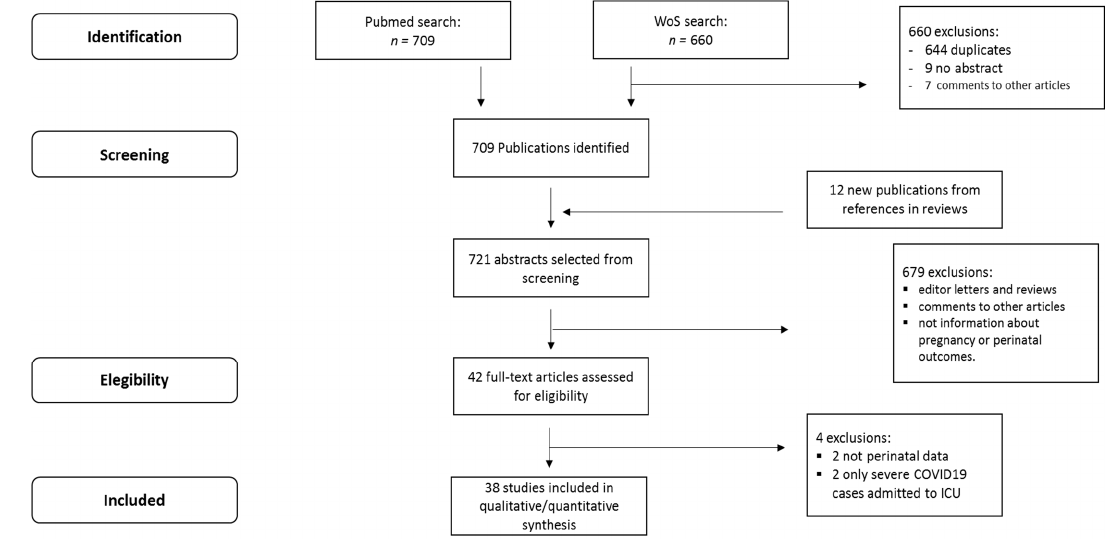
Figure 1. Flow chart of studies retrieved and included in the systematic review.